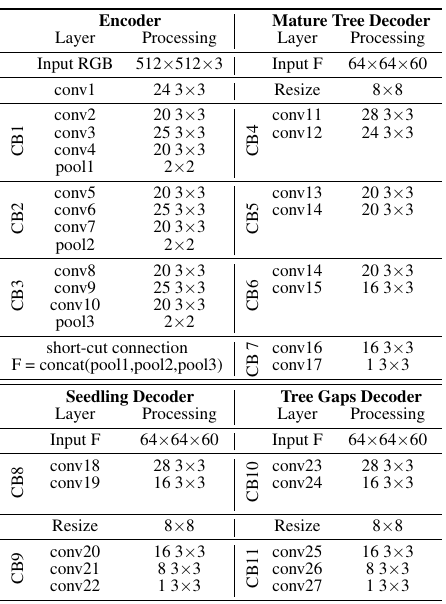
Table 1. Architecture of the